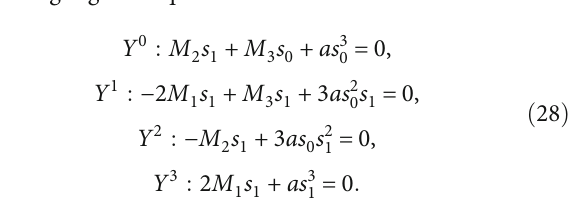
Figure 3: (Color online) Dark soliton solution (24) for Eq. (1) with suitable parameters: a = − 1 , b = 3/2 , c = 1/2 , k B 1 = B 2 = 1 , B 3 = − 1 , and y = z = 1 . ðj u j 2 Þ (a) Perspective view of the dark soliton solution. (b) The overhead view (density plot) of the solution. (c) The corresponding contour plot. (d) The contour plot in spherical coordinates. (e) The contour plot in cylindrical coordinates. (f) Field